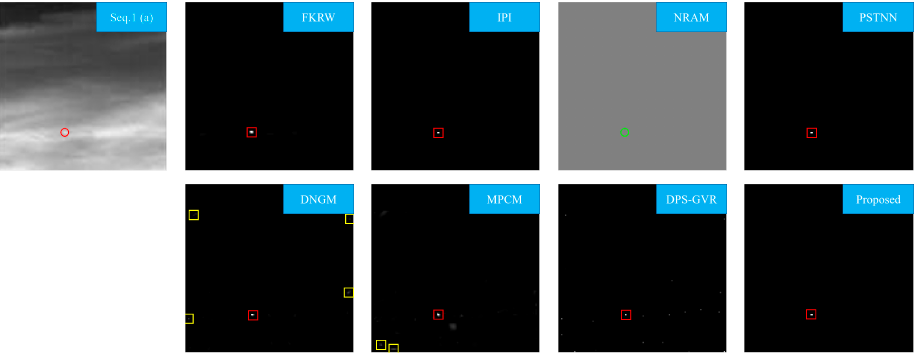
Figure 7. The processing results of the proposed method for the four noise-added images. ( a – d ) 4 infrared images selected from Seq.1. The first row and second show the original images and noise-added images, respectively. The third row displays the enhanced images of our proposed method.